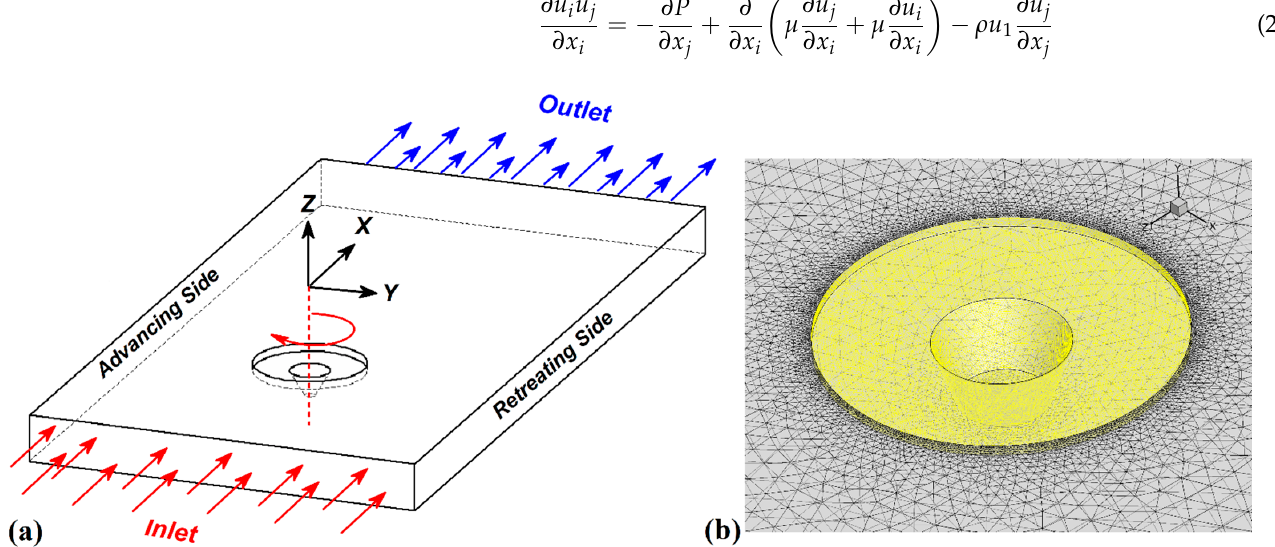
Figure 1. ( a ) FSW simulation domain, ( b ) Meshed